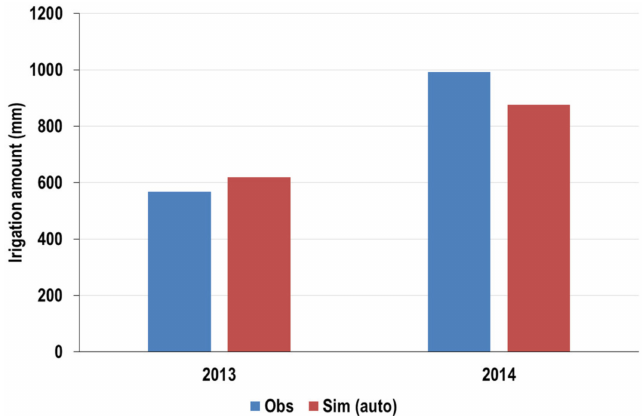
Figure 5. Comparison of observed and simuated irrigation amount for 2013 and 2014 applying the auto-irrigation option of APEX-Paddy model.